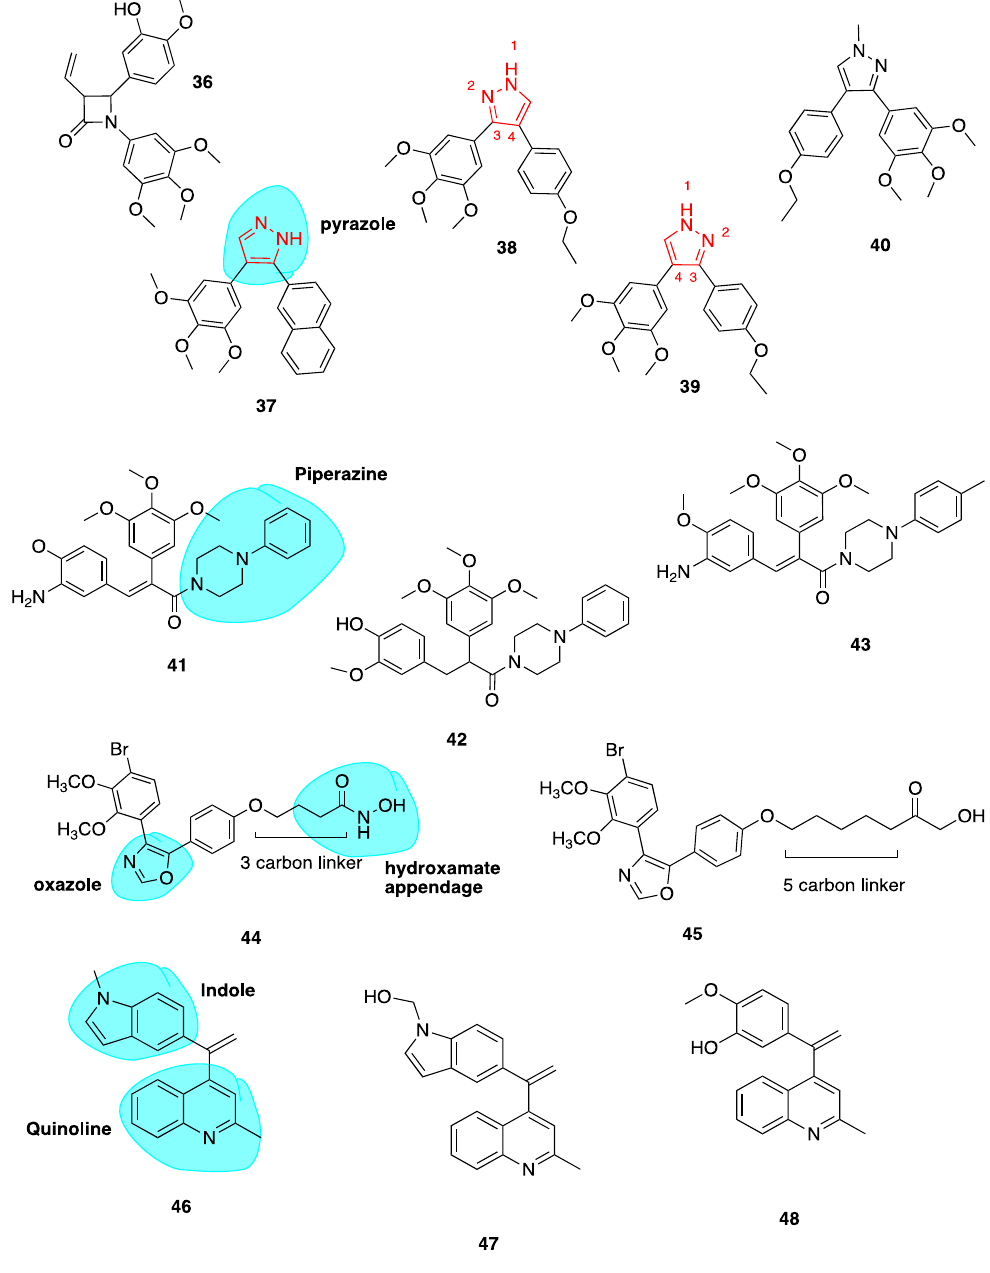
Figure 7. Structures of combretastatin analogues 36 – 48 .